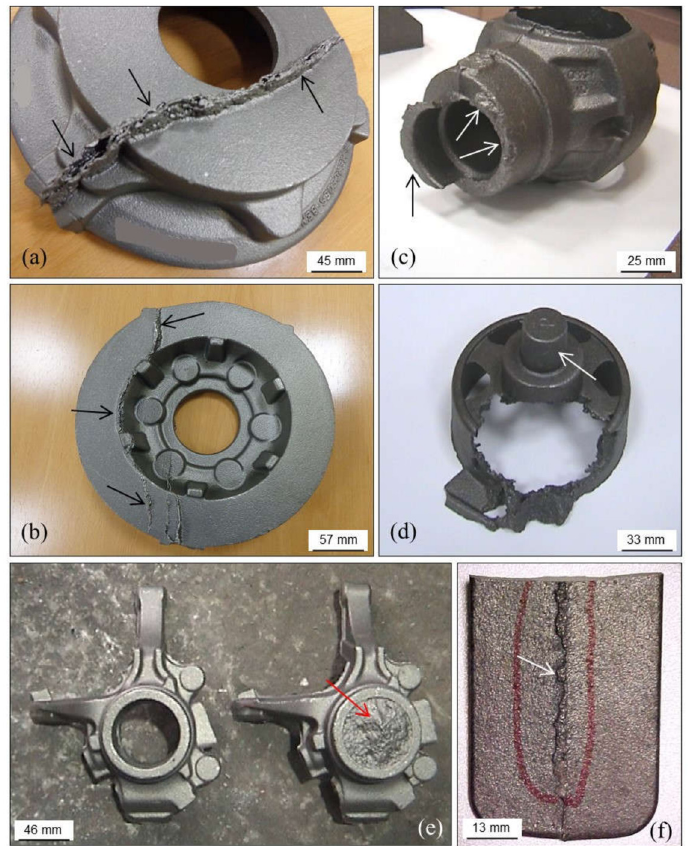
Figure 43. Images ( a , b ) show a metallic wall in a compacted iron casting due to mold cracking. Image ( c ) shows an irregular internal void in a ductile iron differential housing due to a core breakage (white arrows), which also originated a coarse burr (black arrow). ( d ) Effects of massive mold breakage in a grey iron casting due to a lack of setting a core before pouring. ( e ) In the steering knuckle on the right, the internal void was not obtained as the corresponding sand boss broke during molding step. ( f ) Mold breakage in the partition line of a casting due to local stress when closing the